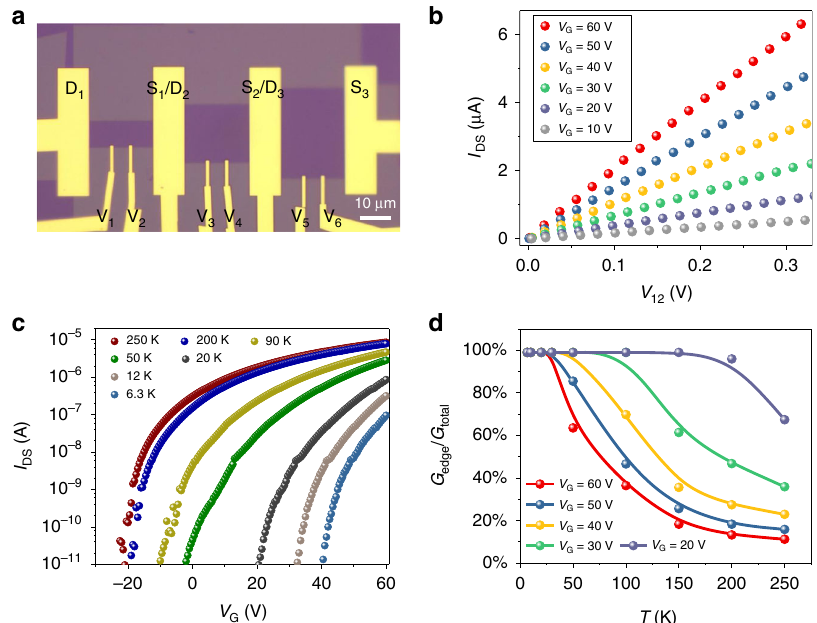
Fig. 1 Edge states conductance quanti fi cation. a Optical image of monolayer MoS 2 FETs with inner probes (V 1 – V 6 ) to sense voltage drop within channel. The scale bar is 10 μ m. b Output ( I device measured at